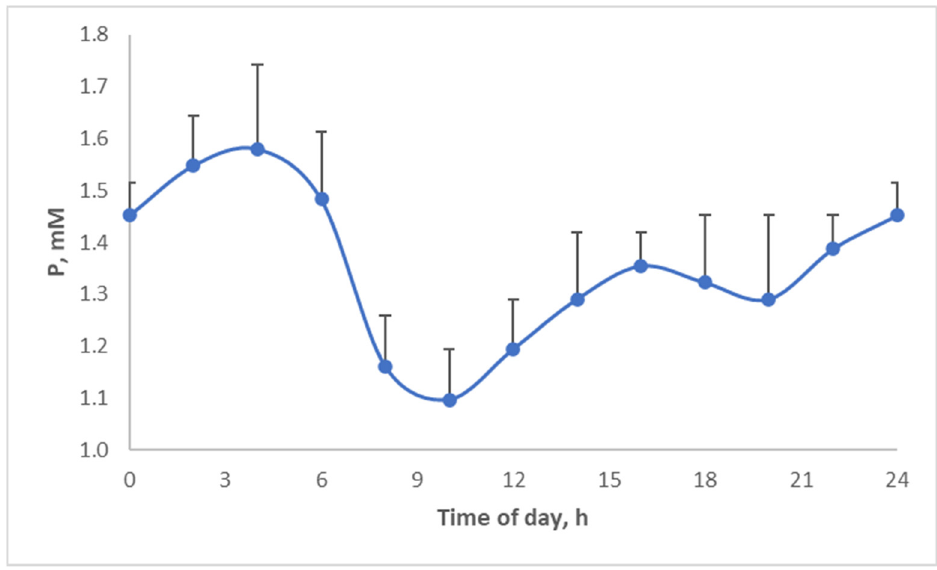
Figure 16. Diurnal phosphate levels [37]. 10.